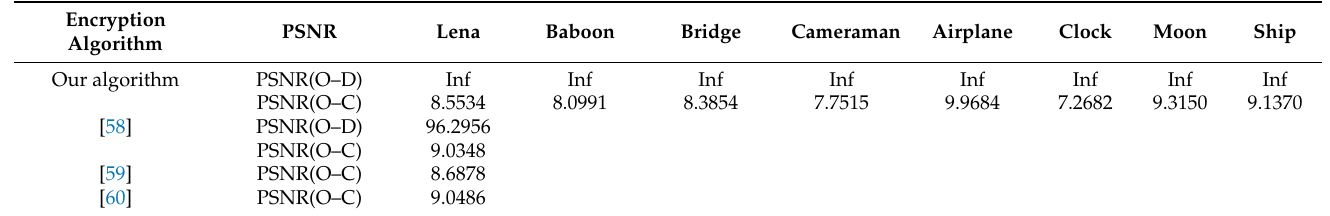
Table 6. The PSNR results between the plain, cipher, and decrypted images: ‘O–C’ stands for the original and cipher images, ‘O–D’ stands for the original and decrypted images.